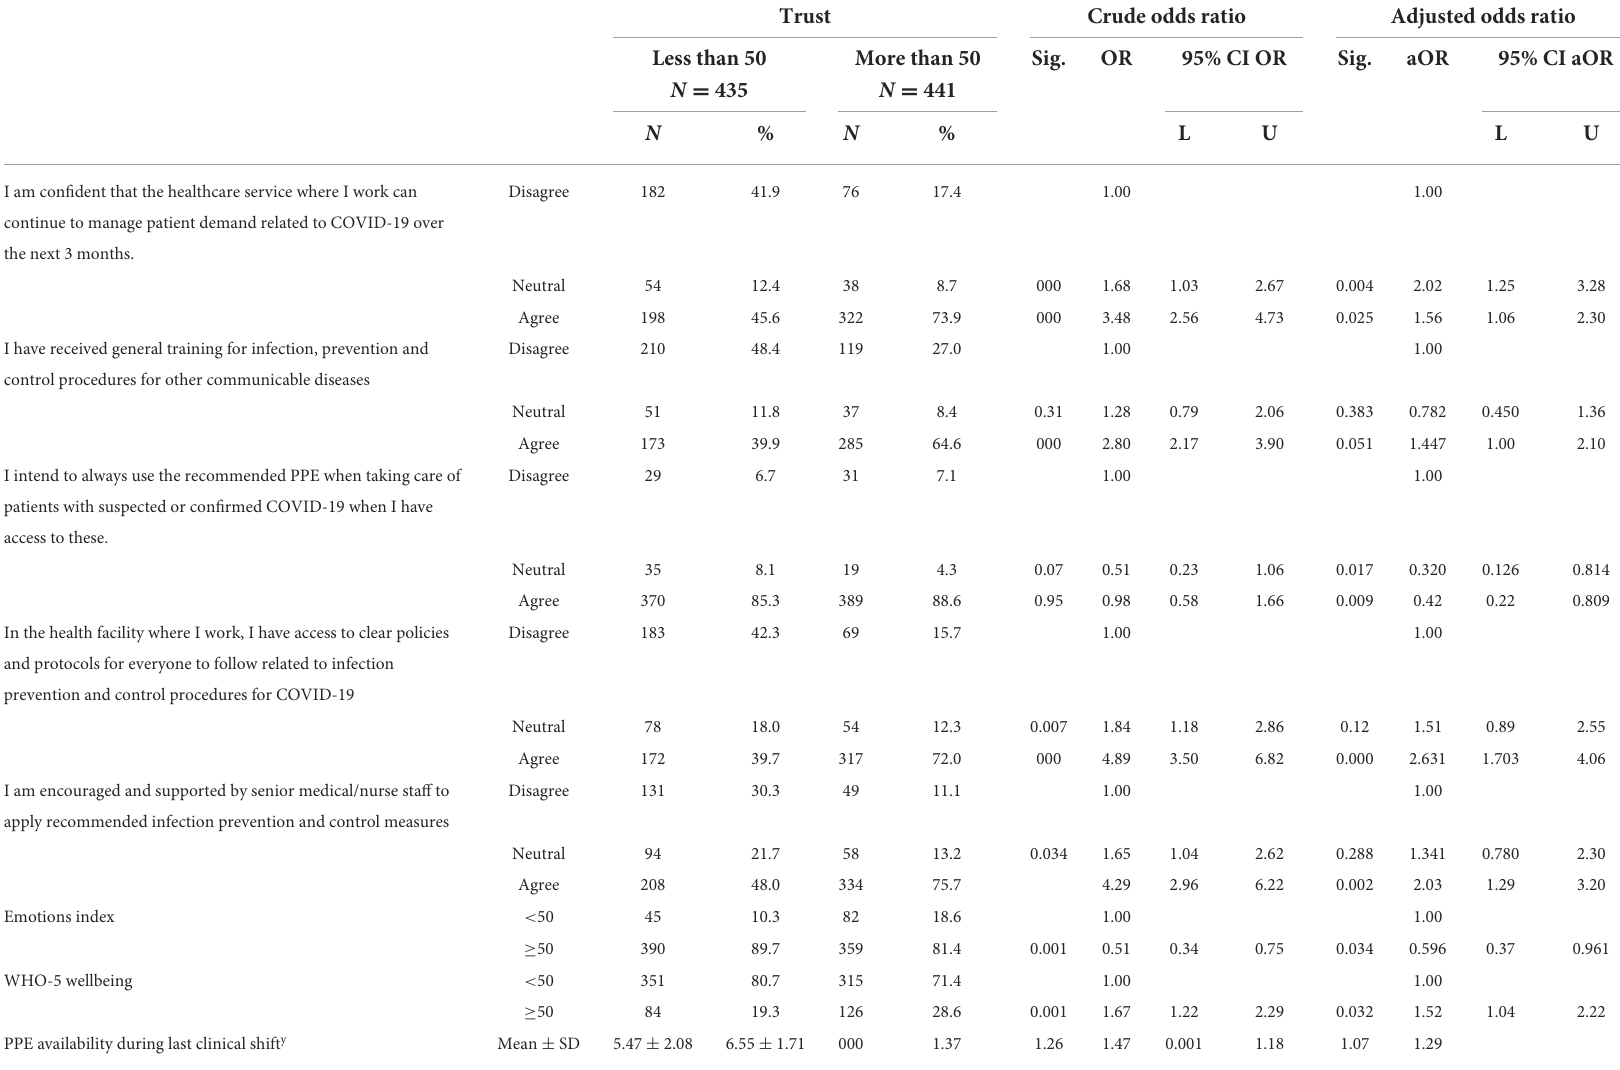
TABLE 3 Binary logistic regression for the association of perceived skills, self-reported environmental context, social influences, emotions, recent use of IPC, emotions index and wellbeing with institutional trust. Trust Crude odds ratio Adjusted odds ratio Less than 50 More than 50 Sig. OR 95% CI OR Sig. aOR 95% CI aOR N = 435 N = 441